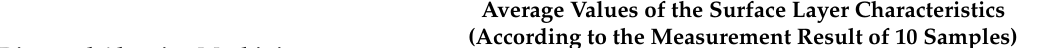
Table 3. Characteristics of the SiAlON ceramic inserts’ surface layer after various diamond abrasive machining methods.